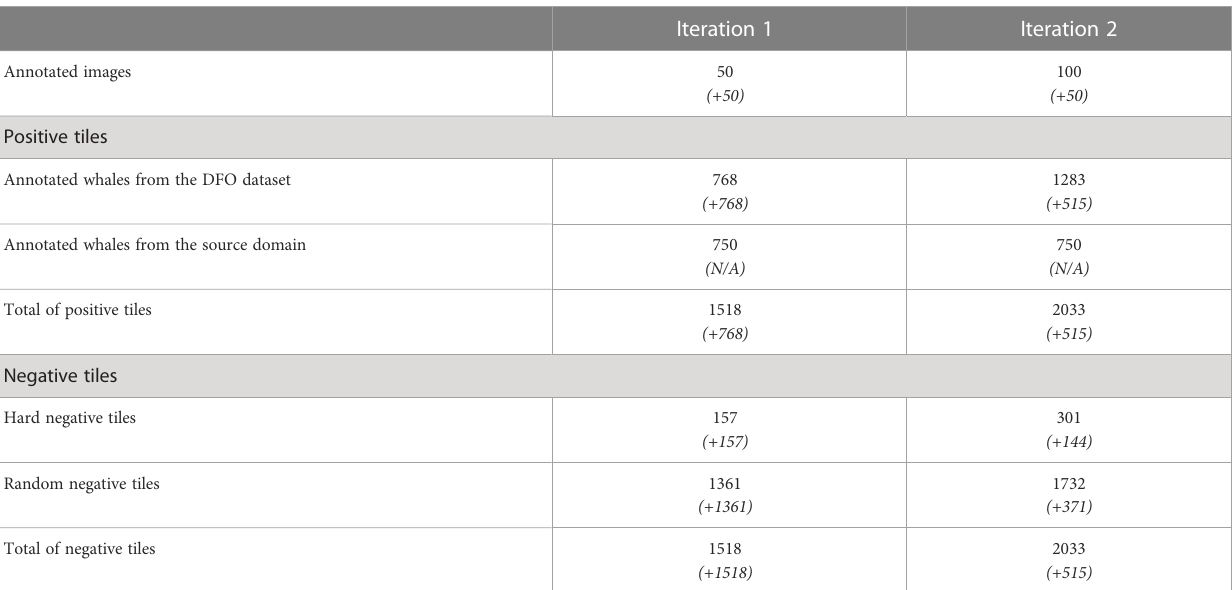
TABLE 2 Summary of the data used in each training